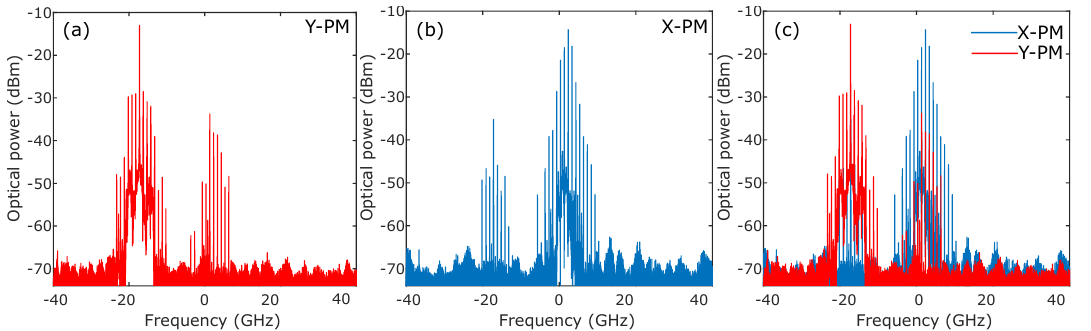
Figure 3. Polarization resolved-optical spectra corresponding to an example of two polarization comb dynamics similar to Figure 2d–f for detuning ∆ ν = 1.6 GHz and injected power P inj = 20 µW. ( a – c ) cor- respond to the optical spectra of Y-PM, X-PM and the superposition of Y-PM and X-PM,